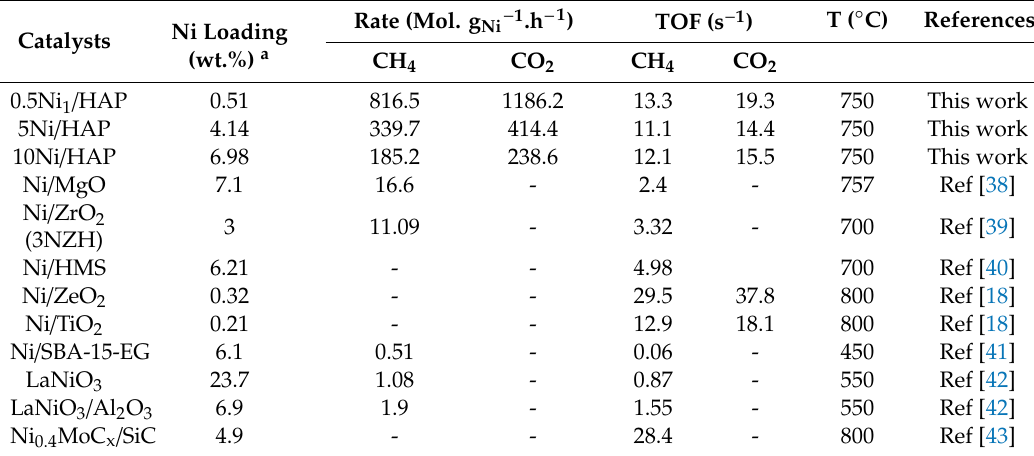
Table 1. Catalytic reaction rate of DRM reaction over di ff erent